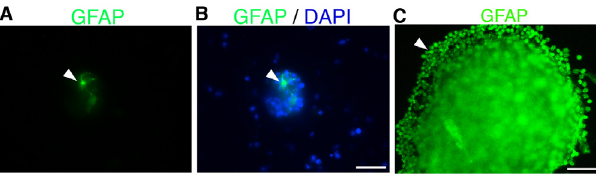
Figure 4. Immunocytochemistry of small and large primary neurospheres. Visual representation of immunocytochemistry staining of a small neurosphere using ( A ) anti-GFAP antibody (green) and ( B ) counterstained with DAPI (blue) after 7 days in vitro (7 DIV) Scale bar = 100 μm. ( C ) Anti-GFAP staining of a large neurosphere 7 DIV. Scale bar = 50 μm Arrowheads represent positive GFAP